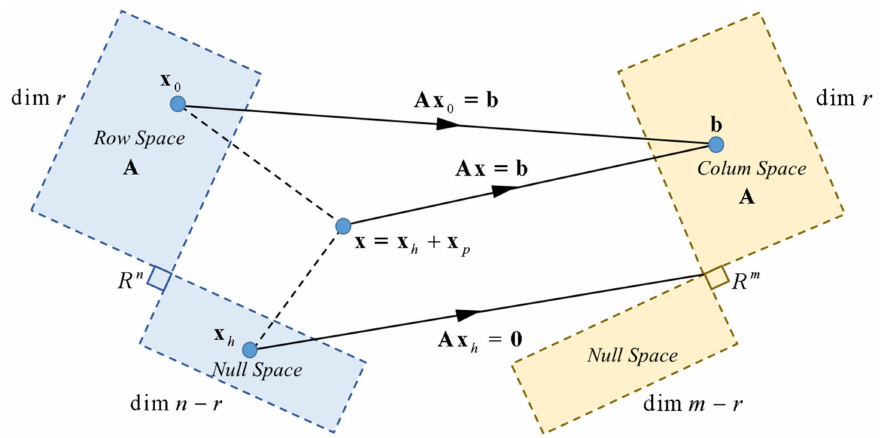
Figure 6. Orthogonal projection of the motion control of the standing